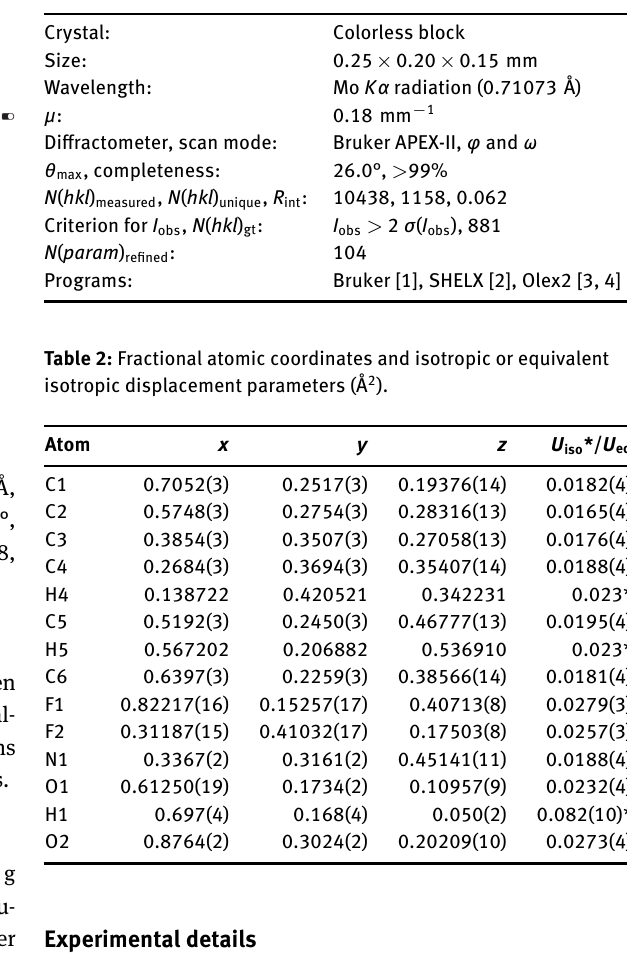
Table 1: Data collection and handling.